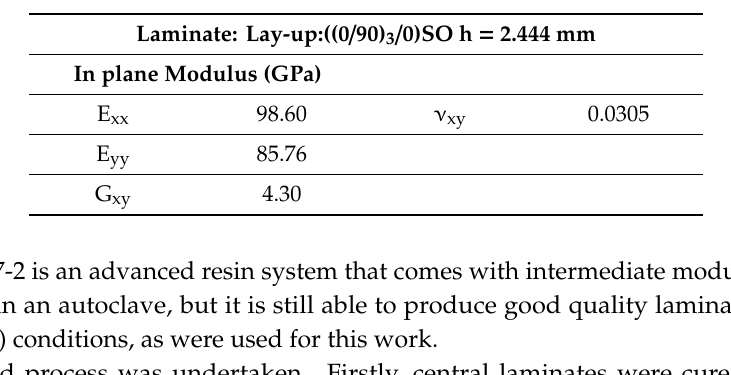
Table 2. Laminate sti ff ness properties. (Calculated by